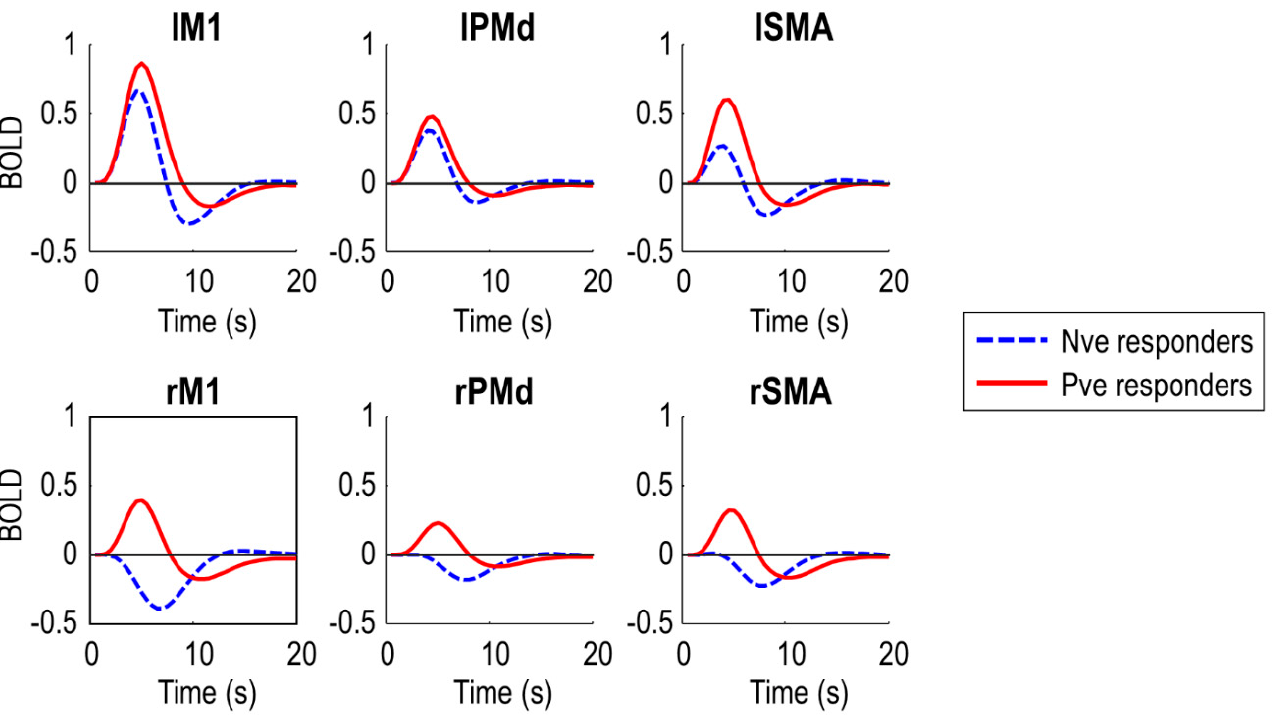
Figure 3. Predicted BOLD responses from the left driving DCM. These responses (first order Volterra kernels) are averaged over subjects from each of the two groups (Figure 1C). The negative (Nve) responder group includes younger subjects, most of whom had negative BOLD responses in rM1. The positive (Pve) responder group includes older subjects, most of whom had positive BOLD responses in rM1. SMA = supplementary motor area, PMd = dorsal premotor cortex, M1 = primary motor cortex.